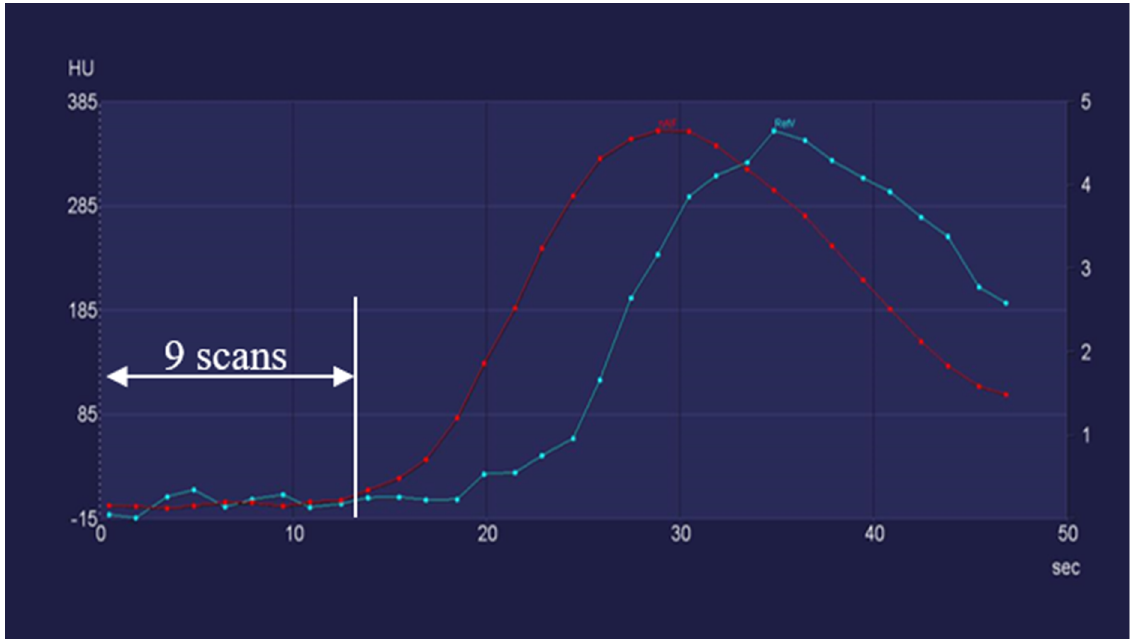
Figure 6. In the case of a slow bolus arrival, the descending slope of the arterial and venous inflow curves becomes truncated.